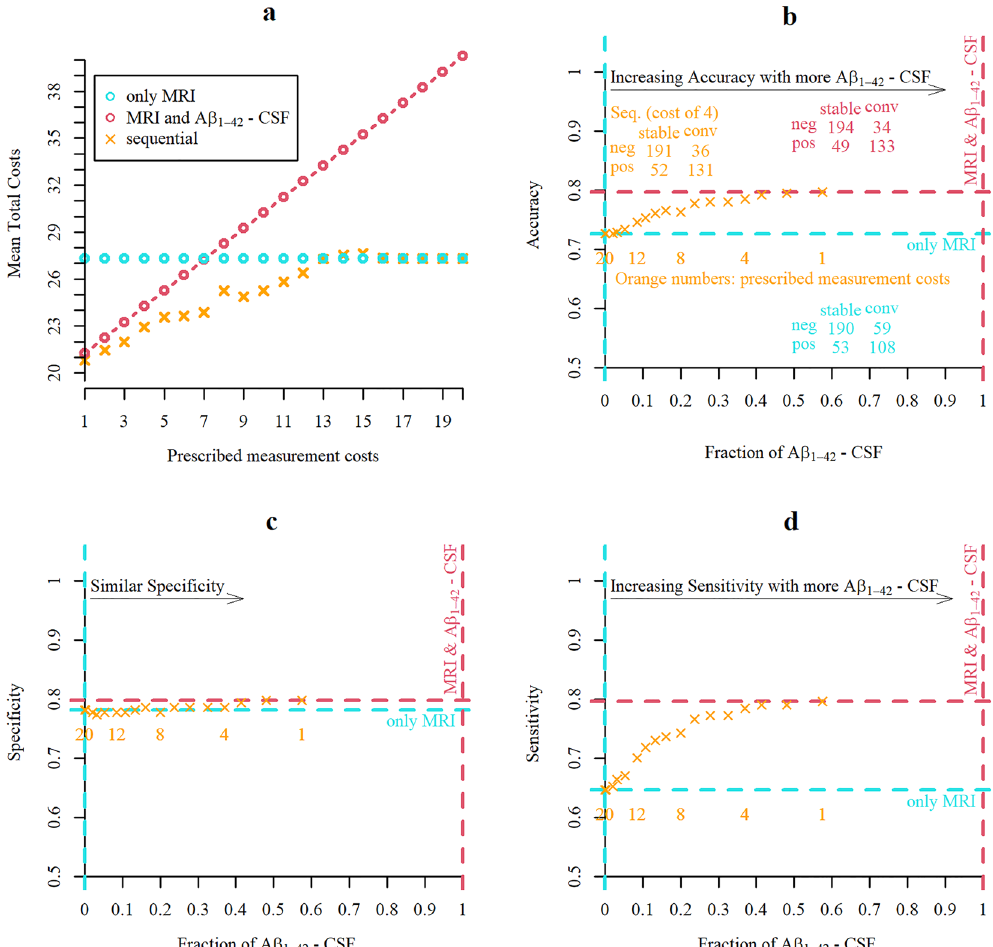
Figure 2. Results of the two-stage classification. Comparison of sequential two-stage classifier and classifications based on fixed panels of measurements (only MRI or always MRI and Aβ 1-42 - CSF for all participants) for varying measurement costs (1–20). Note that the scale of the y-axes in ( a )–( c ) start at 0.5 (chance level) and not at 0 (minimum possible value). a Mean total cost resulting from varying prescribed measurement cost of Aβ 1-42 - CSF obtained with sequential and non-sequential classification strategies. ( b )–( d ) Portion of all cases for which Aβ 1-42 - CSF was included and resulting accuracy ( b ), specificity ( c ) or sensitivity ( d ). For some sequential classifiers represented by the orange crosses the prescribed costs of one Aβ 1-42 - CSF are displayed underneath them (orange